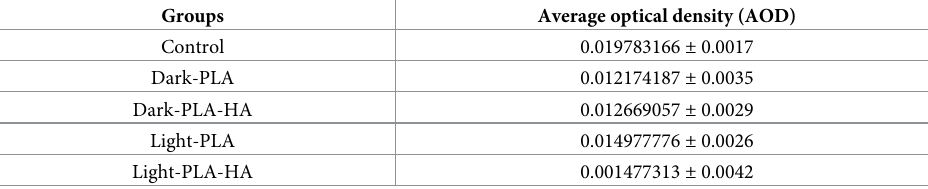
Table 1. The expression level of IL-6 in C . auris -infected tissue sites of different